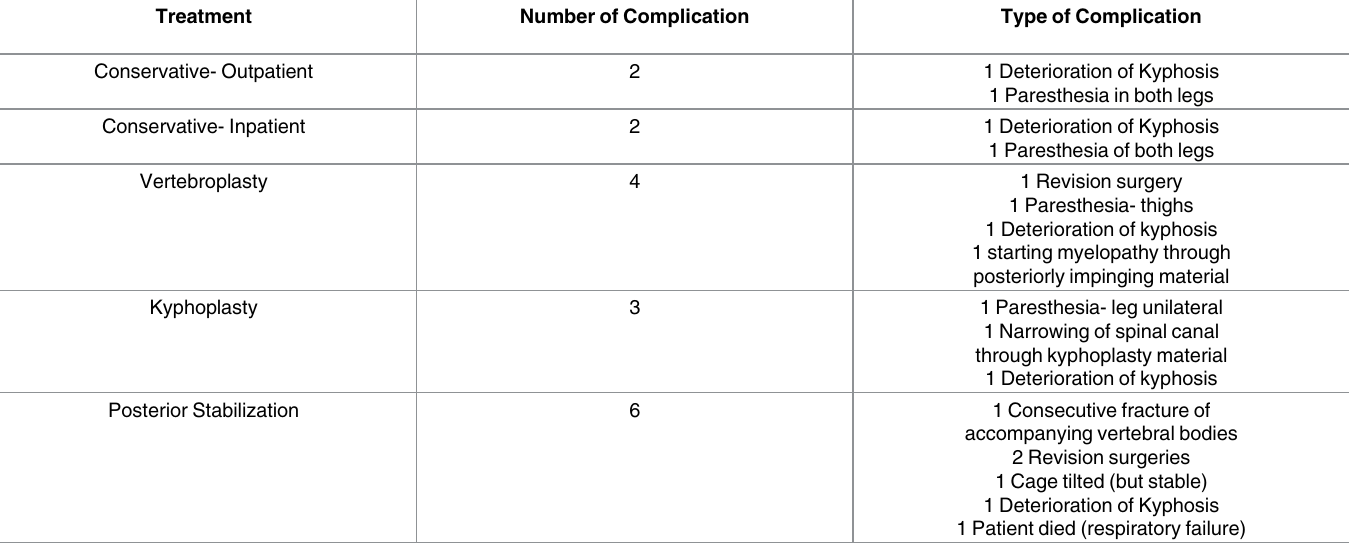
Table 3. Complications. Distributionof